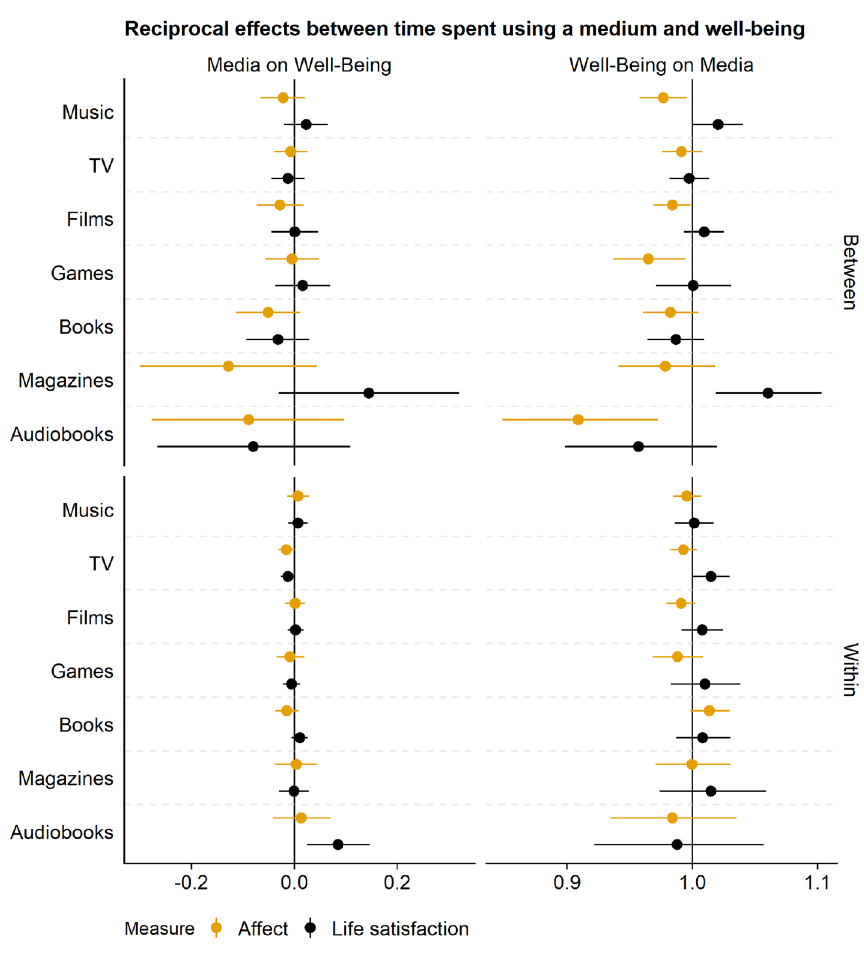
Figure 2. This Figure shows the reciprocal effects between time spent using a medium and well-being. Points represent the mean of the posterior distribution of the effects. Lines represent 95% Credible Intervals. On the left-hand column, coefficients are of the Gaussian models; they represent an unstandardized estimate on the 0 to 10 well-being scale. On the right, coefficients are of the hurdle gamma model, meaning they represent odds of using a medium at all (hurdle part) and time spent using a medium more (gamma part). The top part shows between-person relations. The bottom part shows within-person effects. Estimates are grouped by the well-being measures, affect versus life satisfaction. Note that the range on the x-axis is different from Fig. 1 to show the